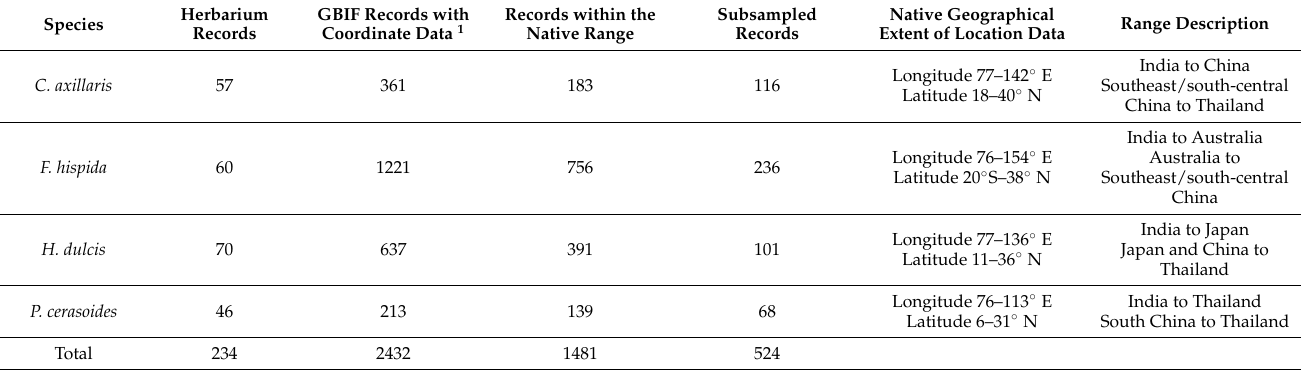
Table 2. Species and the number of data points at different steps of data preparation.